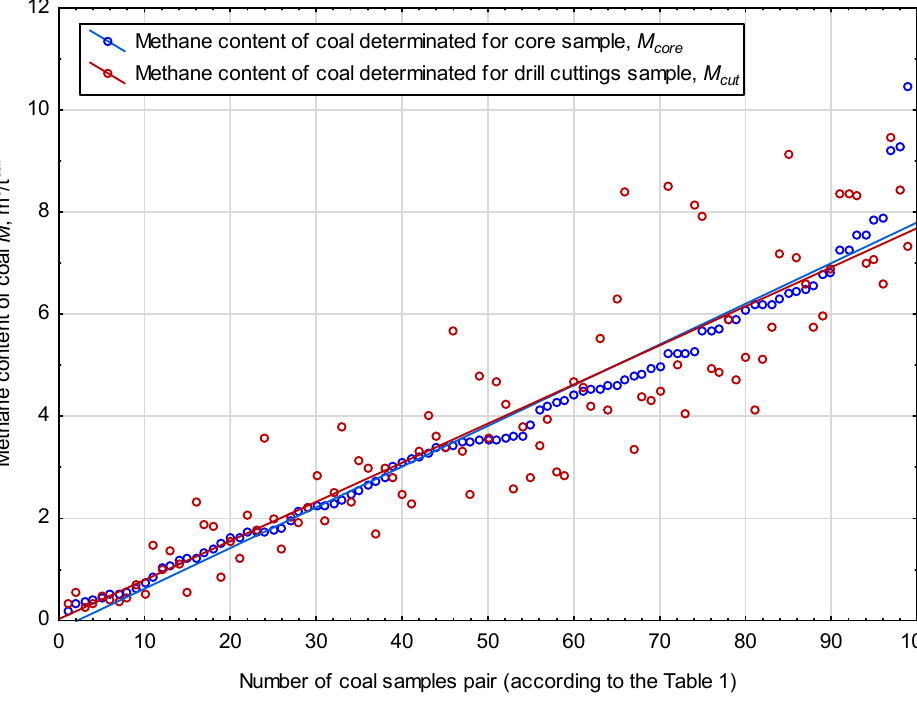
Figure 7. Variation in methane content of coal for drill cuttings samples corresponding to the core samples.